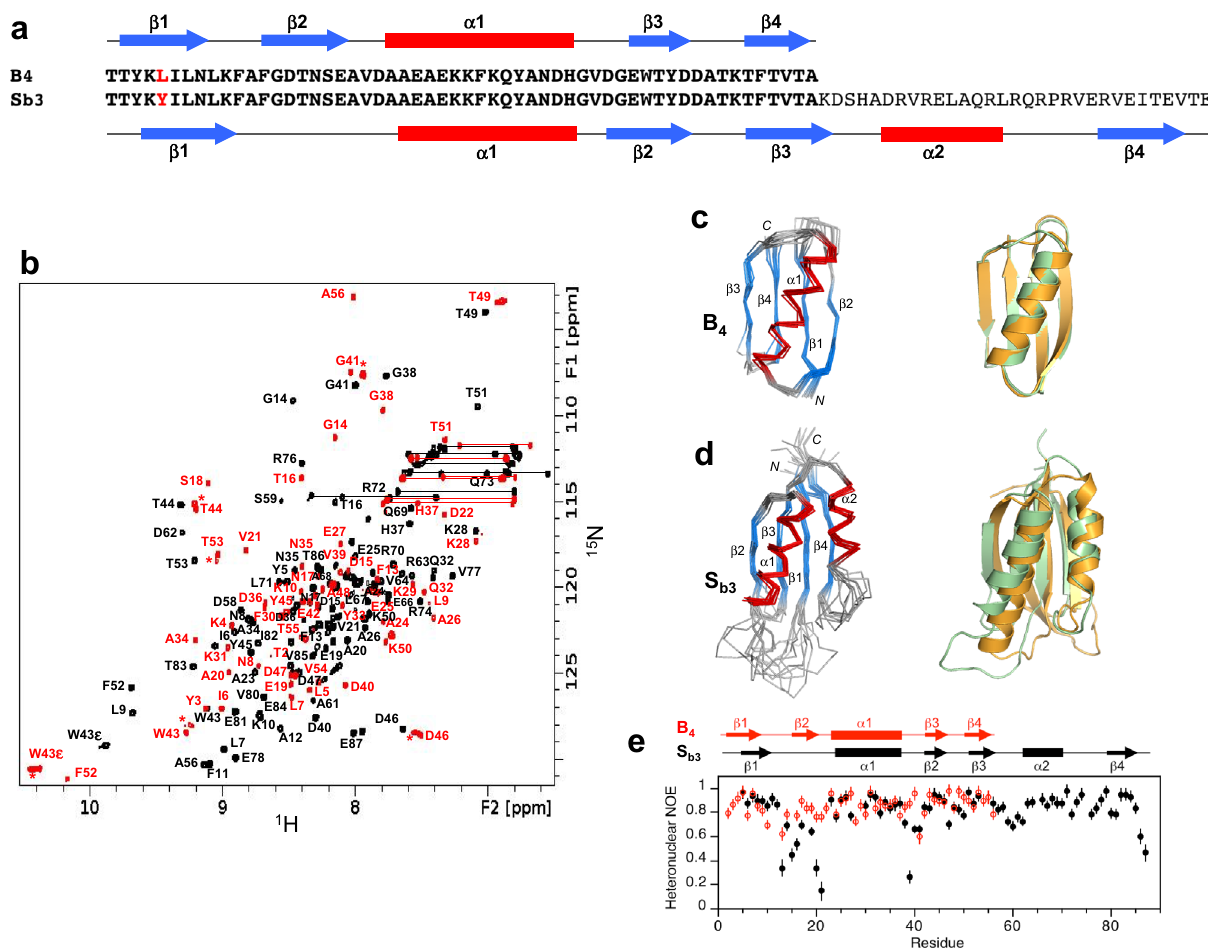
Fig.6|StructureanddynamicsofS b3 andB 4 .a SequencealignmentofB 4 andS b3 , differing by one residue (L5Y) over the 56 amino acid B-region. b Overlaid two- dimensional 1 H- 15 N HSQC spectra of S b3 (black) and B 4 (red) with backbone amide assignments. Spectra were recorded at 25°C. The A56 peak is an aliased signal. Peakslabeled withanasteriskdecreaseinrelativeintensityasthe B 4 concentration is lowered, indicating the presence of a weakly associated putative dimer in addi- tiontomonomer. c Ensembleof10lowestenergyCS-RosettastructuresforB 4 (left